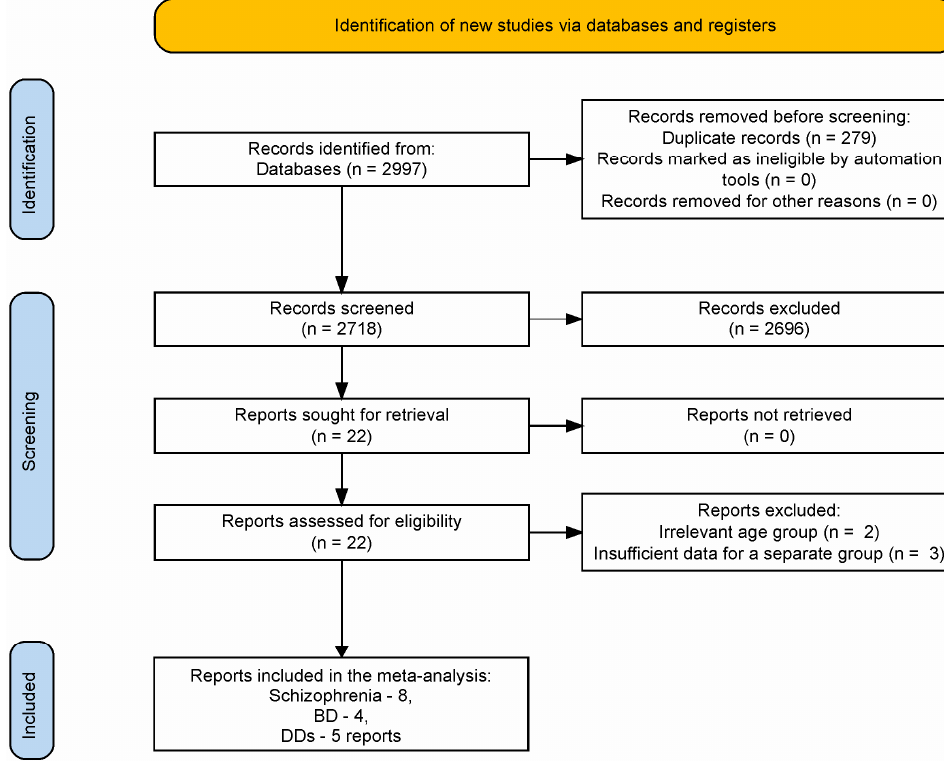
Figure 1. PRISMA flowchart diagram of report screening and selection process. Table 1. Reports of circulating cfDNA concentrations in schizophrenia, bipolar disorder, and depres- sive disorders included in the